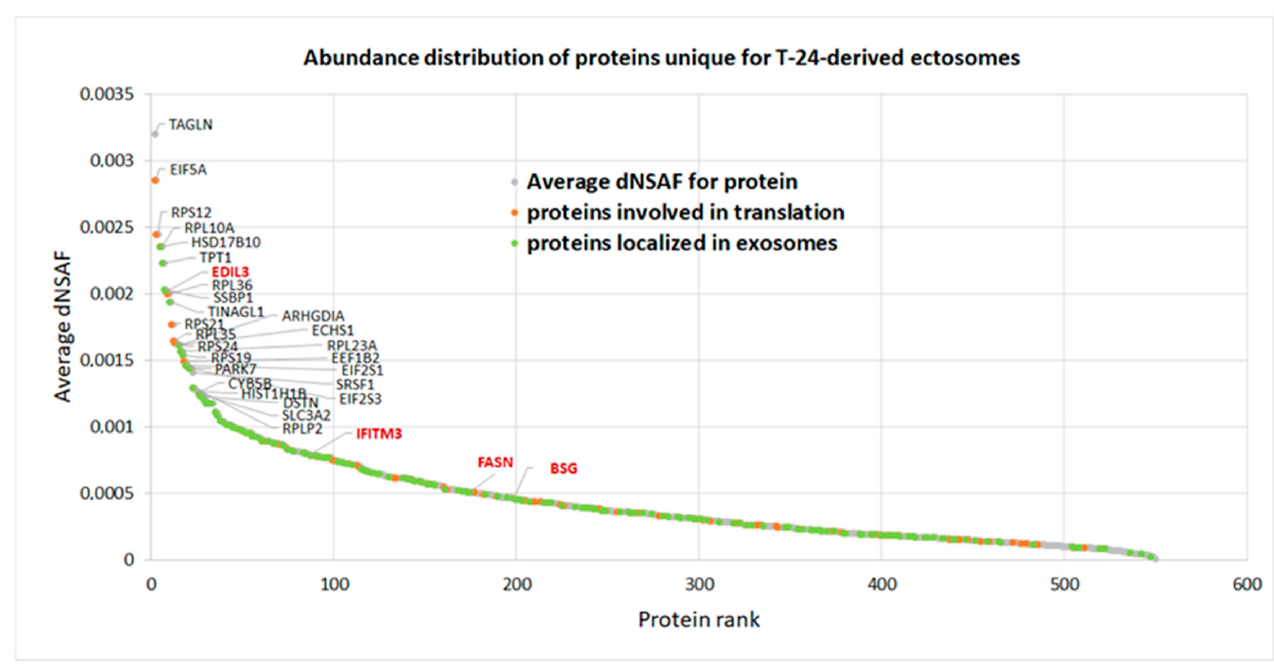
Figure 6. Normalized spectral counting-based abundance of 549 proteins identified uniquely in T24-derived ectosomes (not identified in any replicate of HCV-29-derived ectosomes). The most abundant proteins are labeled. Detailed results can be found in Supplementary Data S3. (dNSAF—distributed normalized spectrum abundance factor).